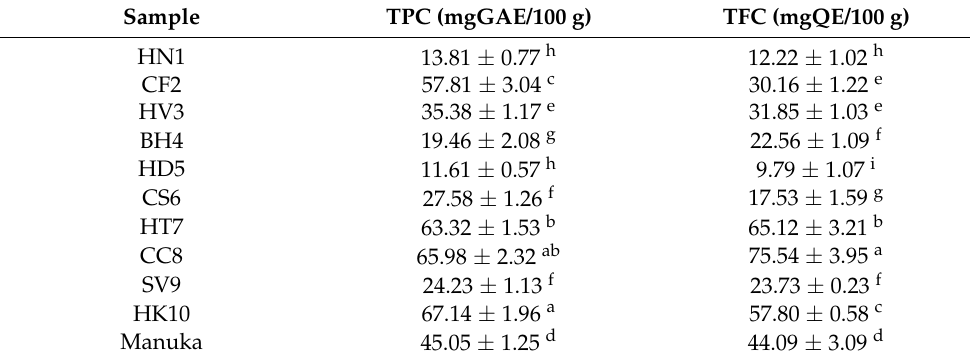
Table 6. Total phenol and flavonoid contents of different types of